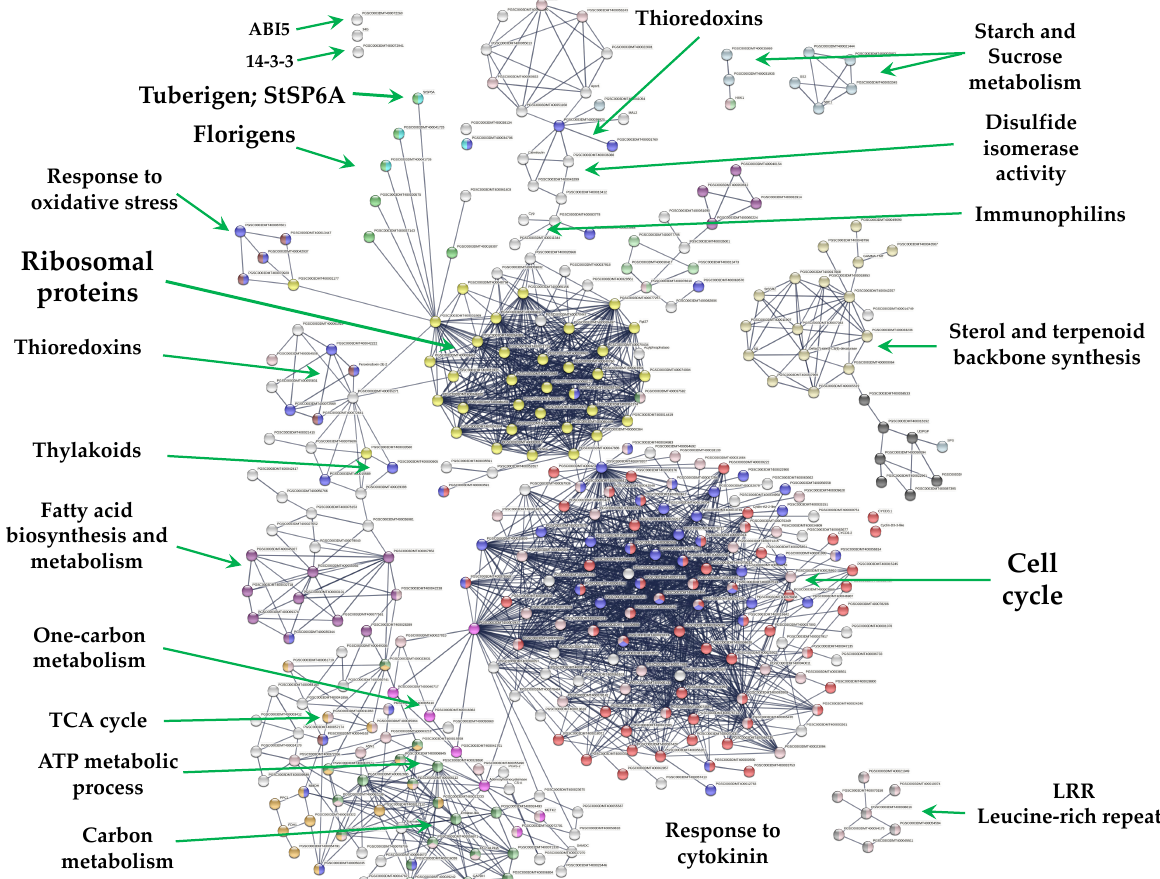
Figure 6. PPI network of up-regulated genes derived from the STRING database of potato S. tuberosum from the transcriptomic-wide analysis with high confidence (0.860). Clusters are highlighted with the name of the function. The figure represents a full network, the edges indicate both functional and physical protein